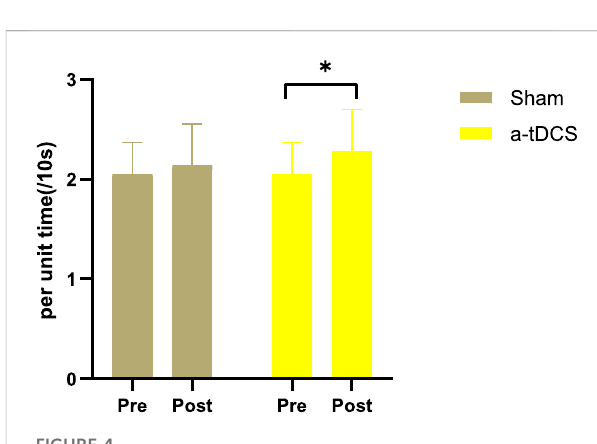
FIGURE 4 Drop in heart rate per unit time. The white bars represent real stimulation compared to pre-stimulation, and the gray bars represent sham stimulation compared to pre-stimulation. “ Pre ” means before stimulation, and “ post ” means after stimulation. Note: * indicates p <